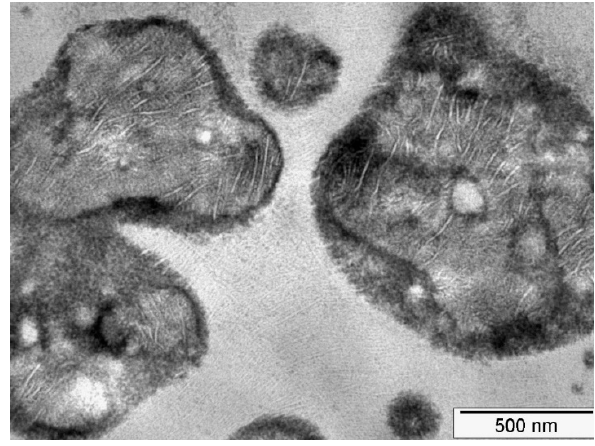
Figure 7. Transmission electron microscopy (TEM) image of the typical particle morphology in the present series of reactor copolymers. Cross-hatched lamellae are visible in the matrix phase. The dark areas are EPR rubber. The light grey blobs inside the particles are LLDPE like polyethylene (PE) and the whiter parts inside the particle are matrix occlusions. (Courtesy of Peter Neuteboom (Sabic Geleen)).